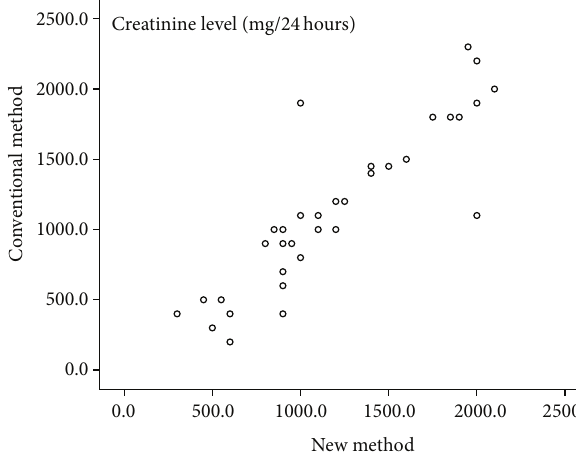
Figure 3: Conventional plot: Urine creatinine levels in 24 hours as measured by conventional and new